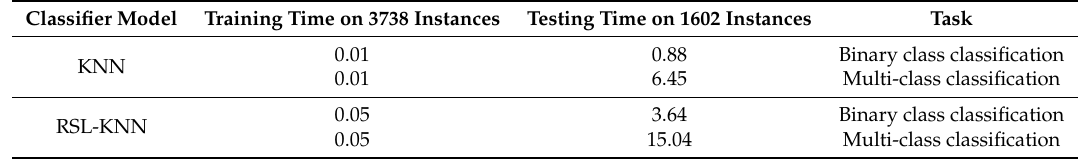
Table 8. Efficiency results of RSL-KNN and